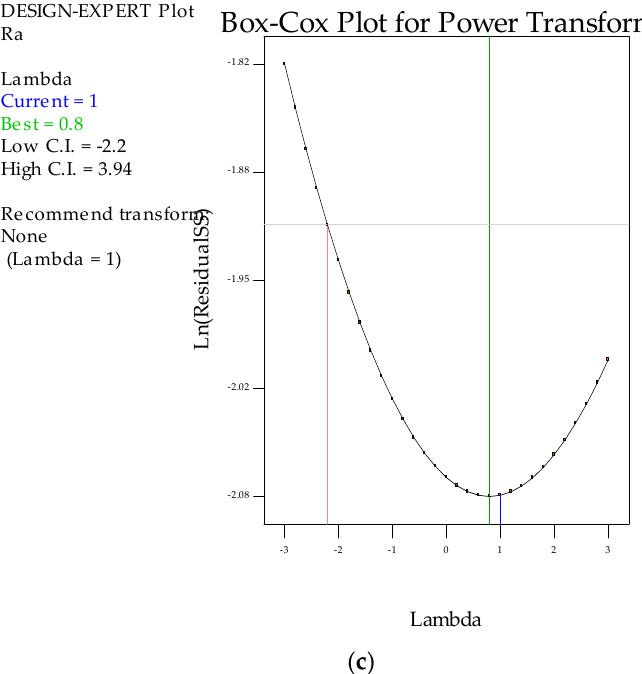
Figure 2. Box-Cox plots. ( a ) Cutting forces; ( b ) Tool wear; ( c ) Surface roughness.